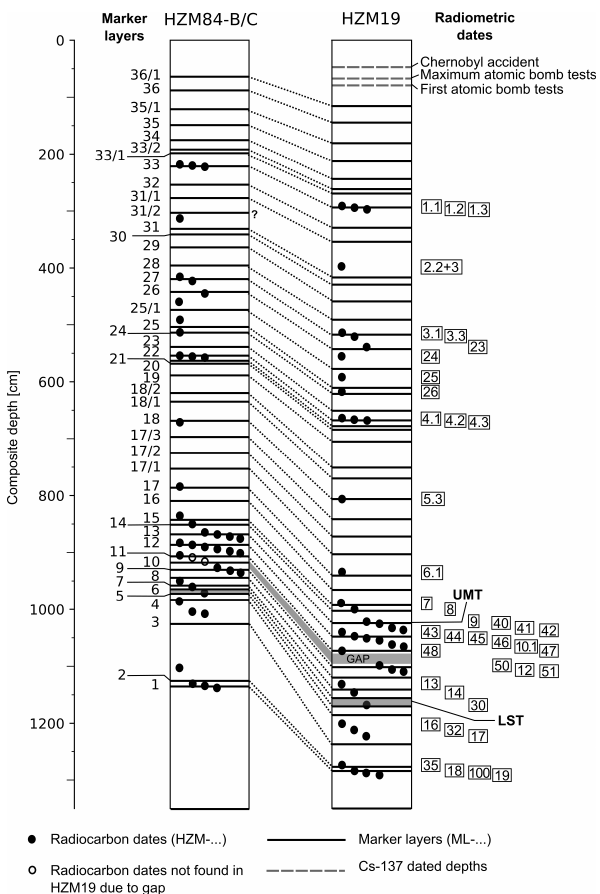
Figure A2. Correlation of HZM84-B/C and HZM19. Positions of marker layers (MLs, indicated to the left) are marked as solid lines and connected by dotted lines between both profiles. Positions of radiocarbon dates (numbers indicated in rectangular boxes to the right) are marked as solid circles. Dotted grey horizontal lines refer to Cs-137-dated depths. The positions of the Ulmener Maar Tephra (UMT), Laacher See Tephra (LST), and the technical gap are indi-